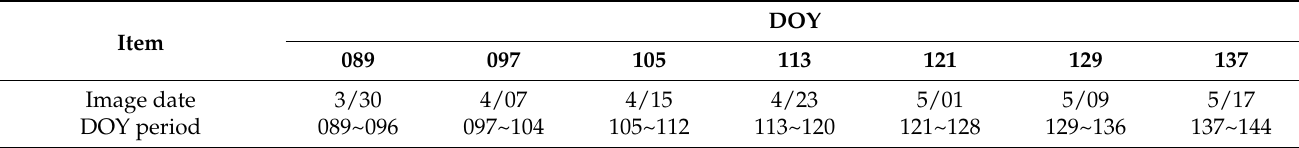
Table 1. Dates and periods of 7 MOD09A1 images.